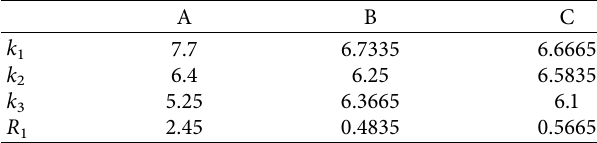
1 ) of paste filling.